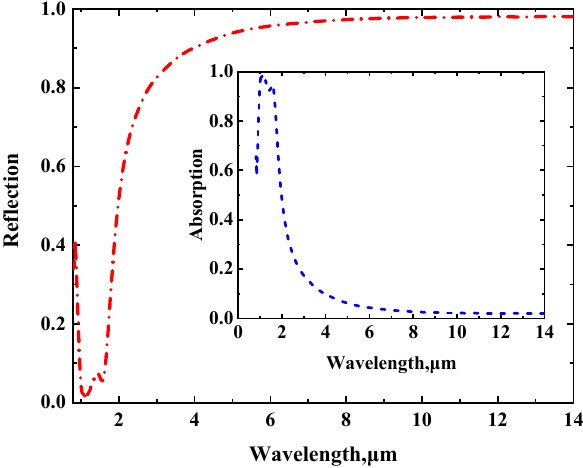
Figure 8. Absorption spectra at different polarization angles.